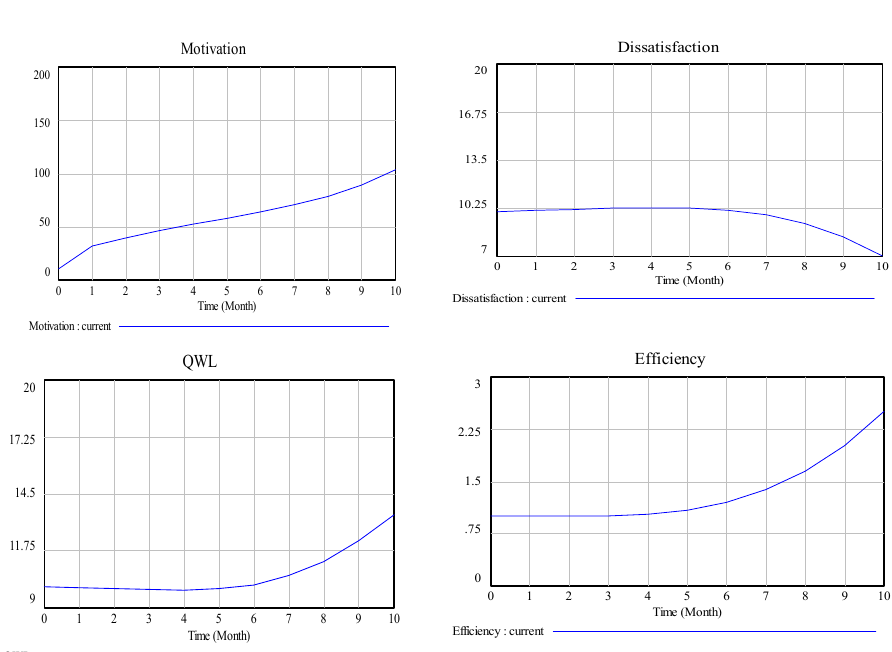
Fig. 4: The behavior of variables in the status quo Fig. 4. The behavior of variables in the status